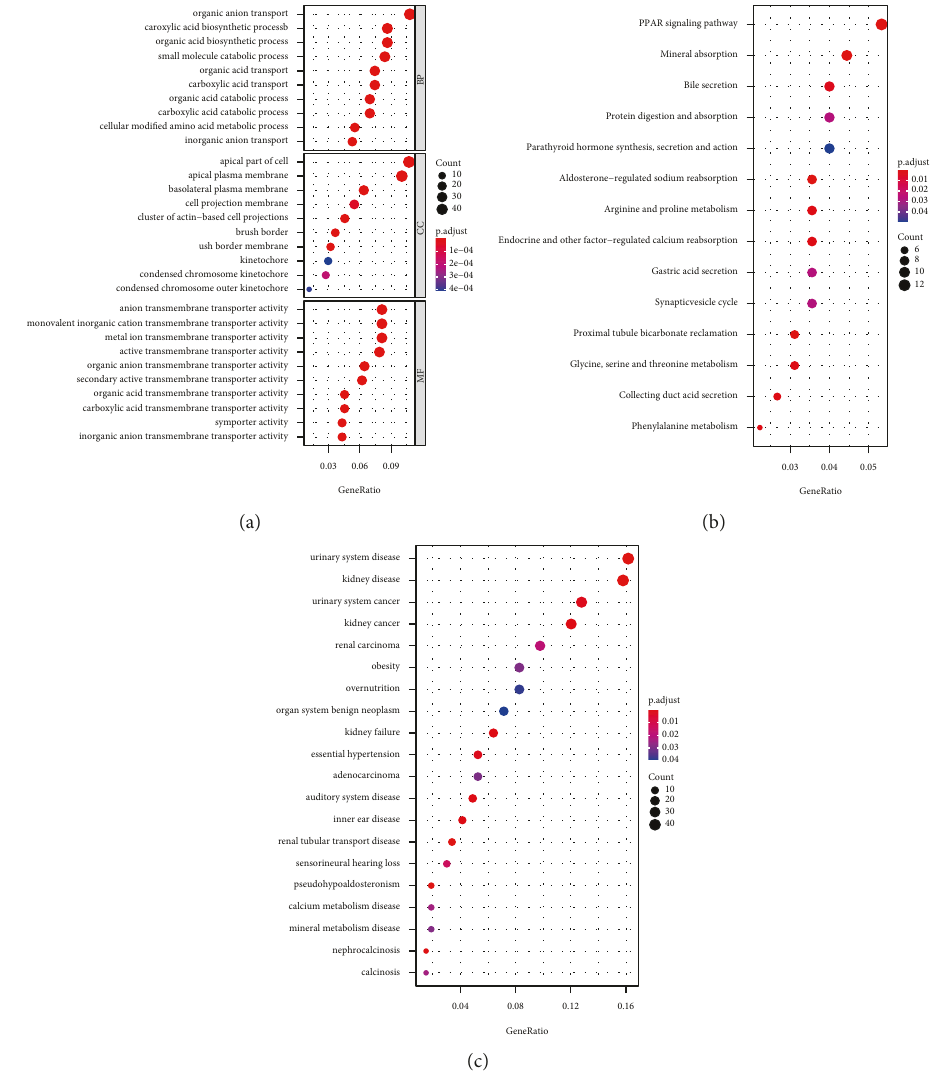
Figure 3: Functional enrichment analysis for WT-specific mRNAs. (a) The top 10 predominant GO.BP, GO.CC, and GO.MF terms are shown in the dot plot. (b) All the 14 significantly enriched KEGG pathways are shown in the dot plot. (c) The DO enrichment analysis showed the top 20 WT-specific mRNAs associated with